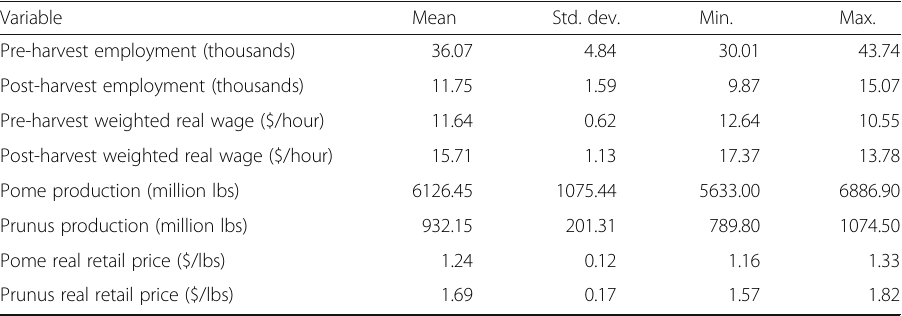
Table 2 Summary